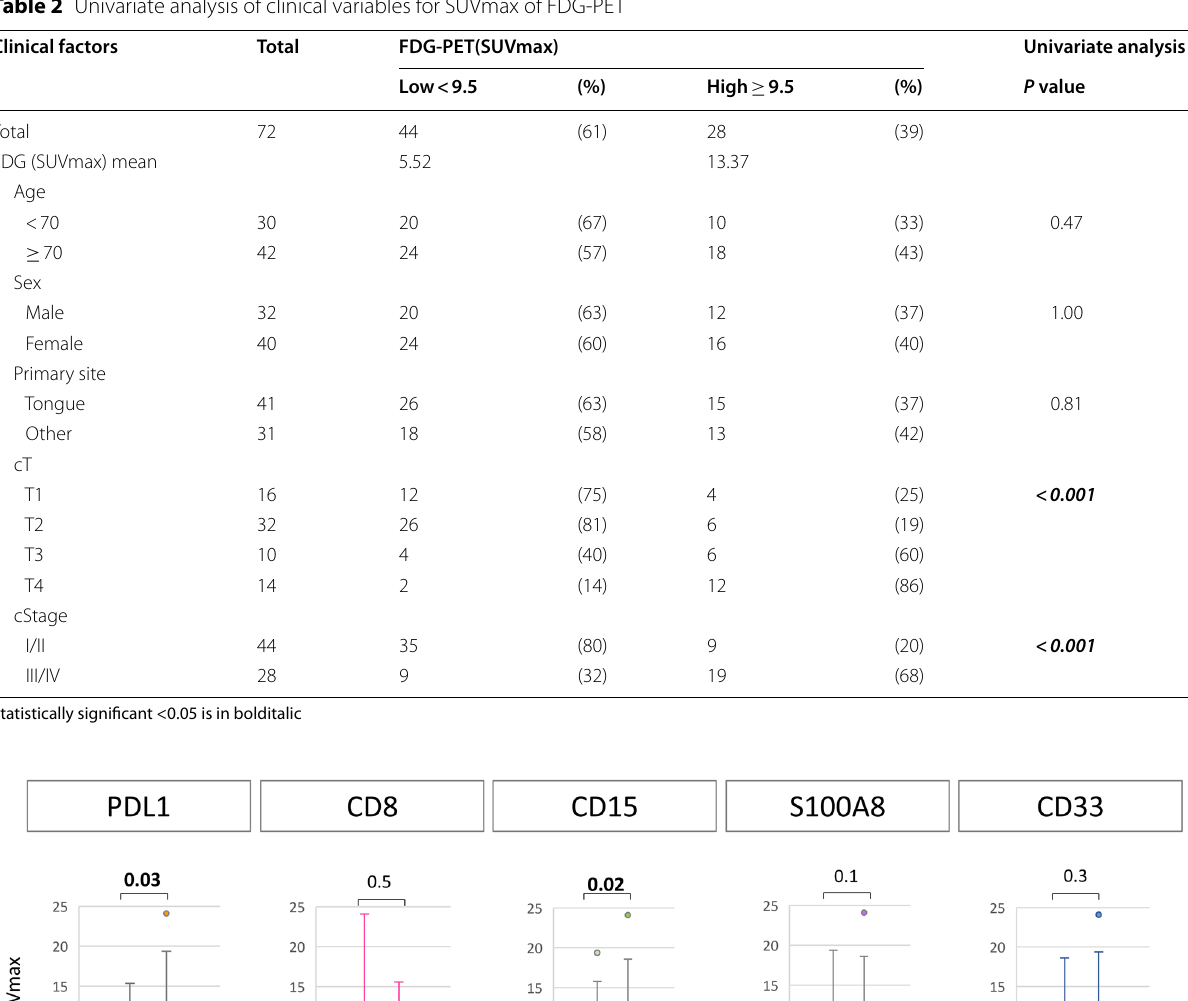
Table 2 Univariate analysis of clinical variables for SUVmax of FDG-PET